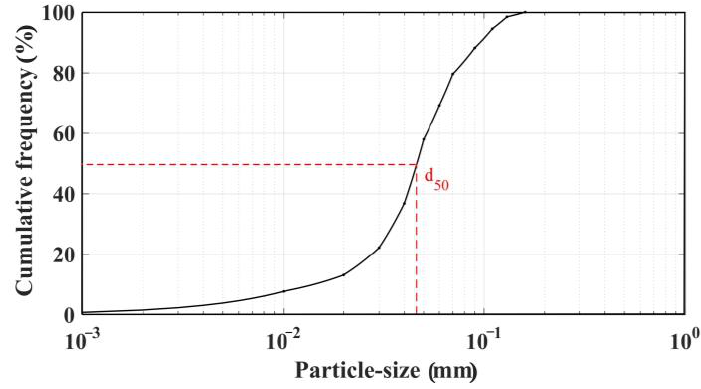
Figure 3. Particle-size distribution curve of the test soil.